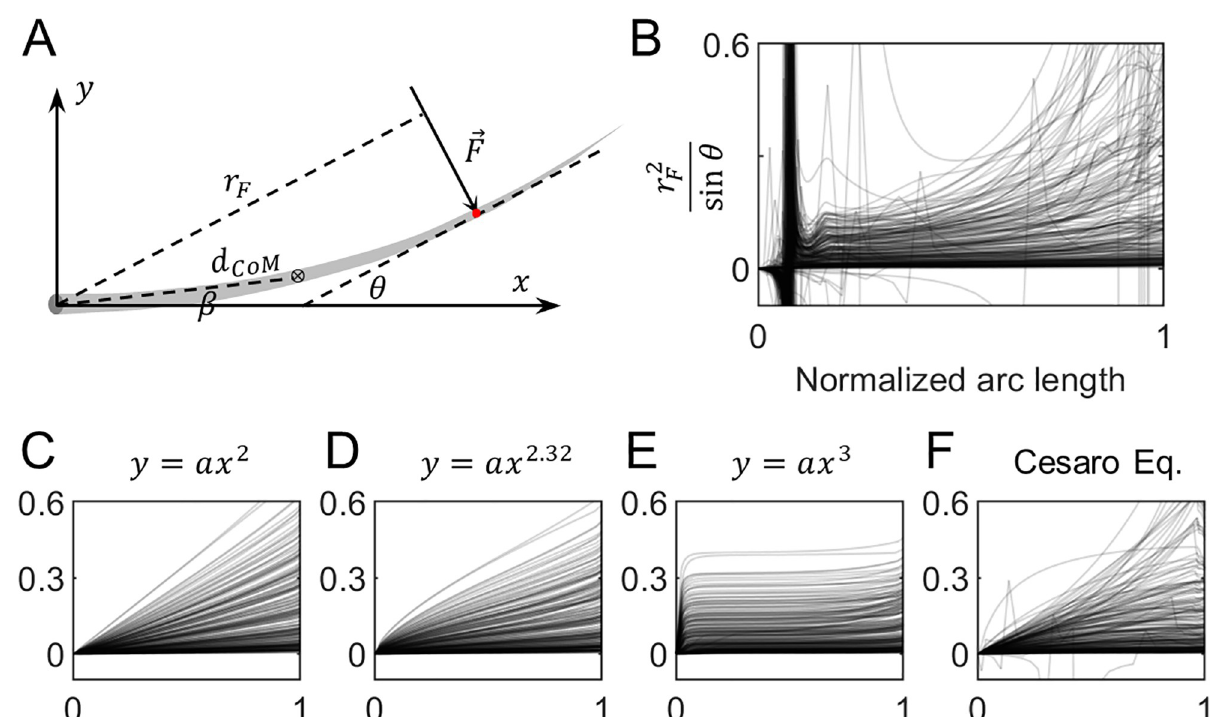
Fig 9. The influence of curvature model on mechanical analysis. (A) A whisker reference frame is defined with the whisker in standard orientation. The whisker is allowed to rotate about the z-axis at its base upon contact. The center of mass (CoM) of the whisker is β degrees from the x-axis, with a straight-line distance d CoM to the whisker base. The tangent at the point of contact (red) forms an angle θ to the x-axis. The whisker model is assumed to be frictionless, so the external force of magnitude F is perpendicular to the tangent at the location of contact, with a distance r F to the whisker base. The total mass (M) and the moment of inertia (I) about the z-axis are also known. (B) The second factor of the right side of Eq 10 is evaluated along the whisker arc length for 225 raw whisker shapes. (C-F) Each panel has the same axes as (B) but results are shown from using different models for approximating the whisker shape. Note that for all panels B- F, the y-axis is truncated at 0.6 for visual clarity.